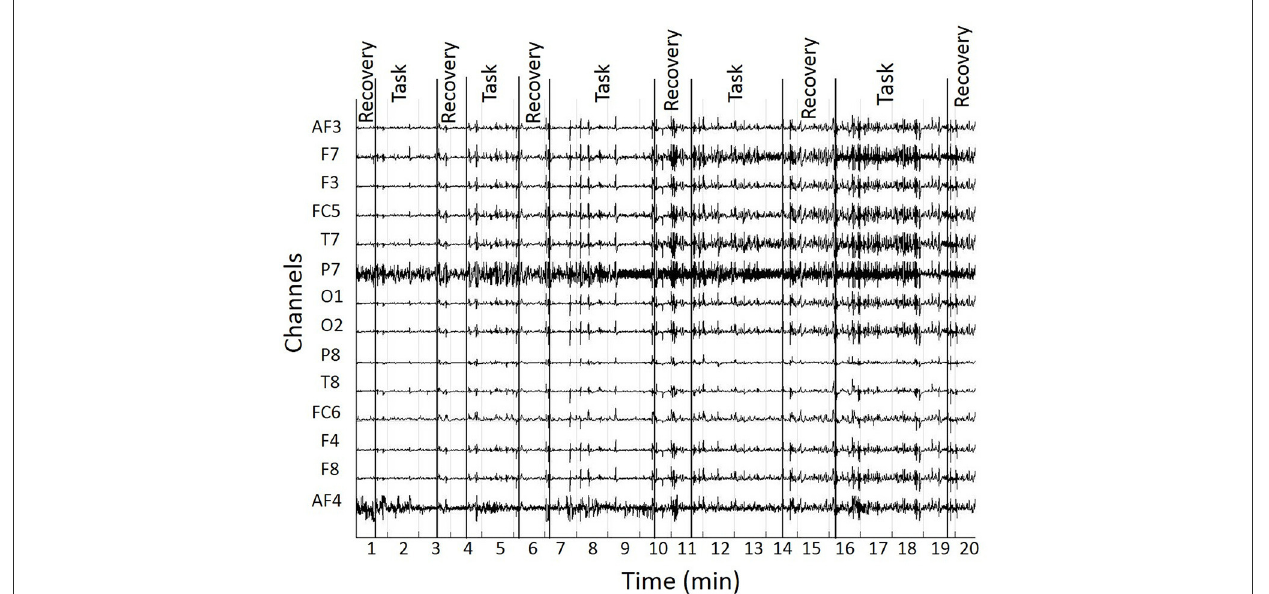
FIGURE4 Raw EEG signal from one participant. It was segmented in epochs of recovery and performance during the task training.